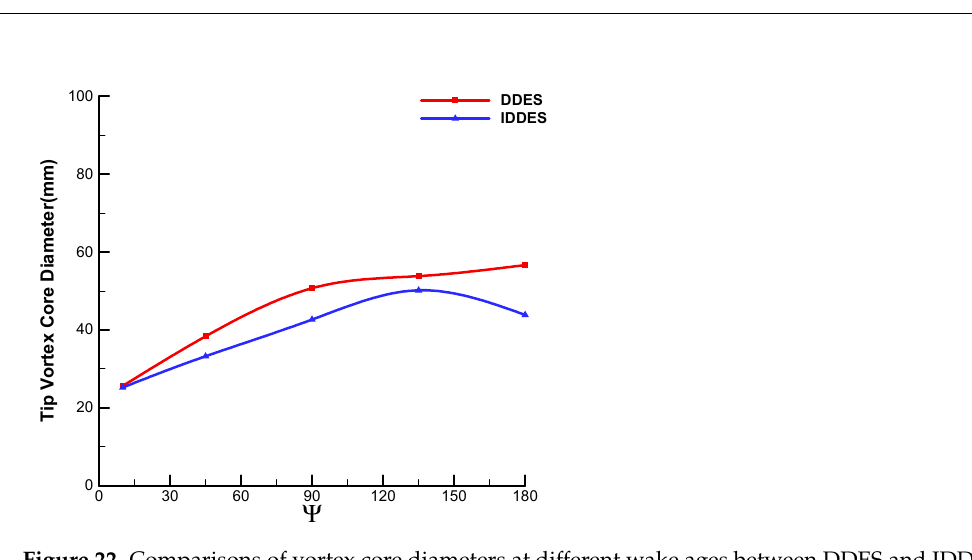
Figure 22. Comparisons of vortex core diameters at different wake ages between DDES and ID- DES.